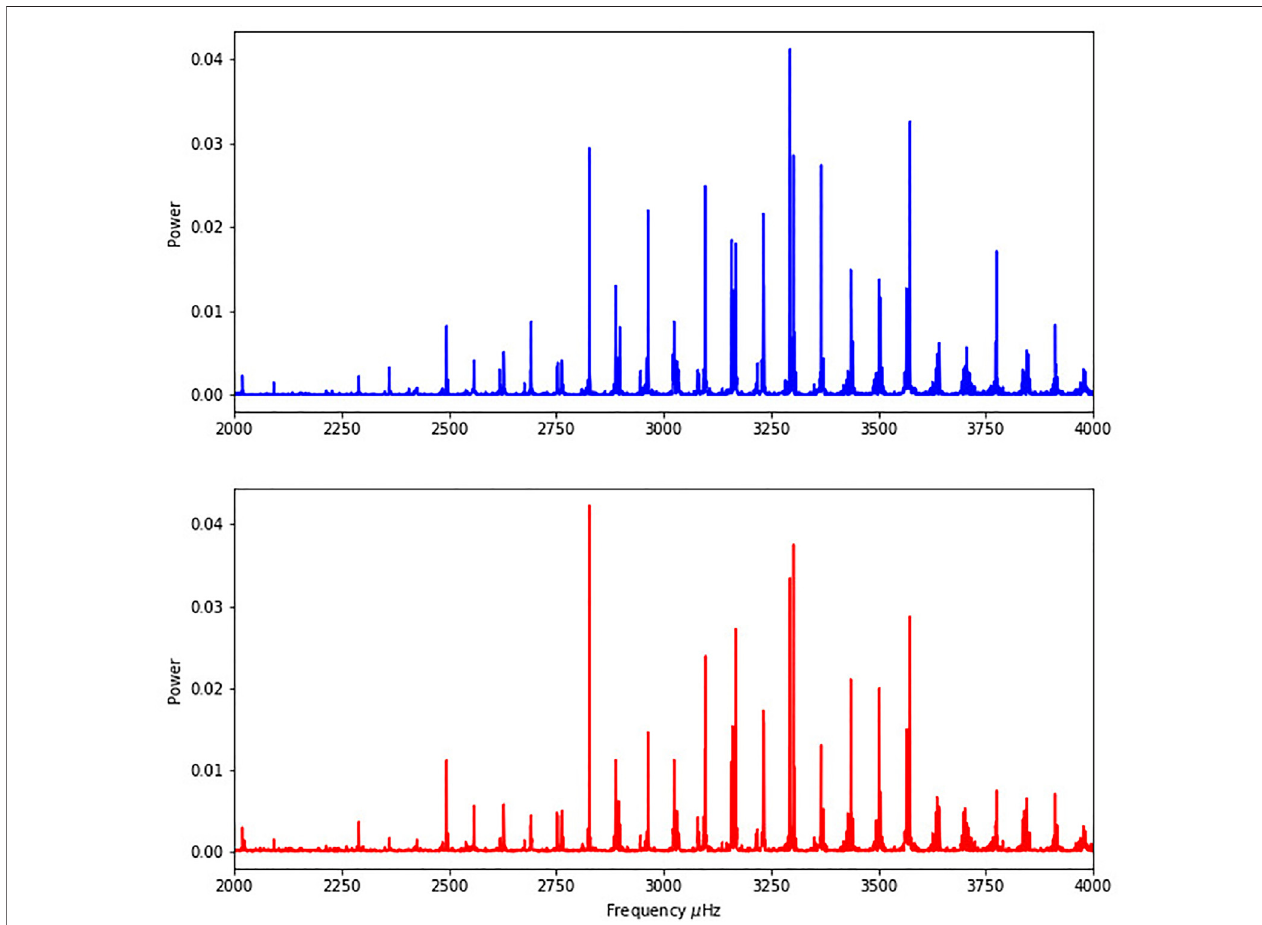
FIGURE 1 | Modi fi ed (red) and Classical (blue) Fourier Transforms of the SoHO data obtained during 16 days, at the region between 2,000 and 4,000 μ Hz . Note thatthemaindifferencesbetweenbothtransformsinthisrangeisthehigheramplitudeinthecaseofthequaternionFouriertransform,compatiblewithabettersignal-to- noise